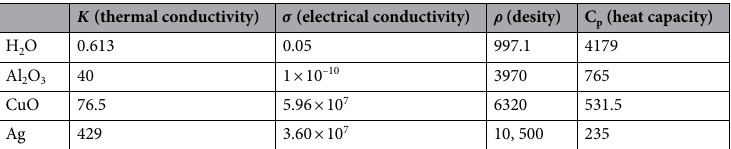
K (thermal conductivity) σ (electrical conductivity) ρ (desity) C p (heat